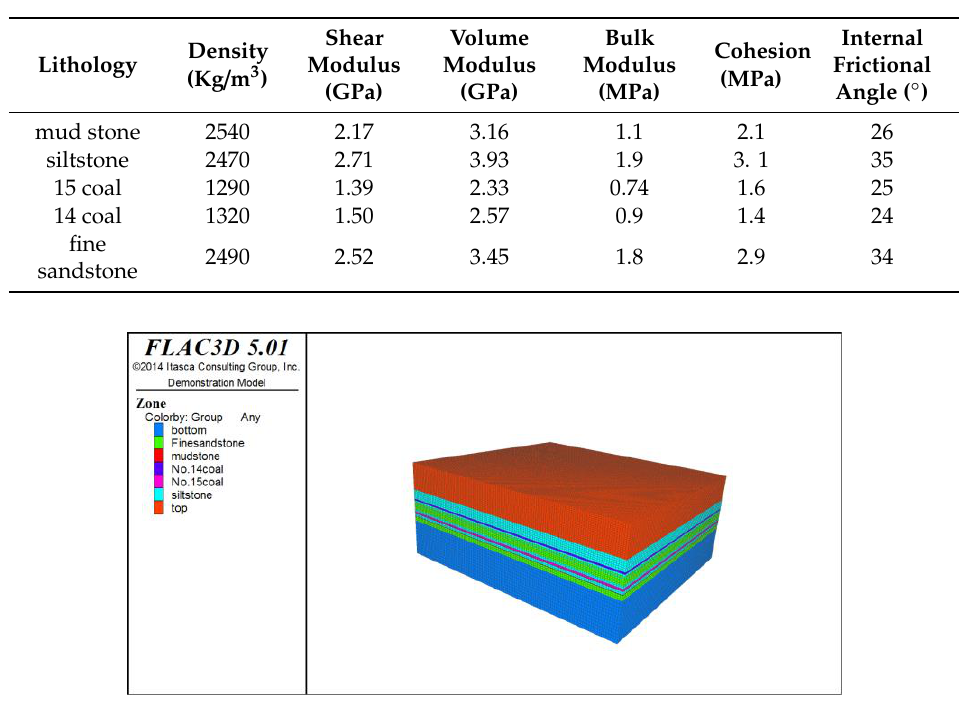
Figure 4. 3D view of model.